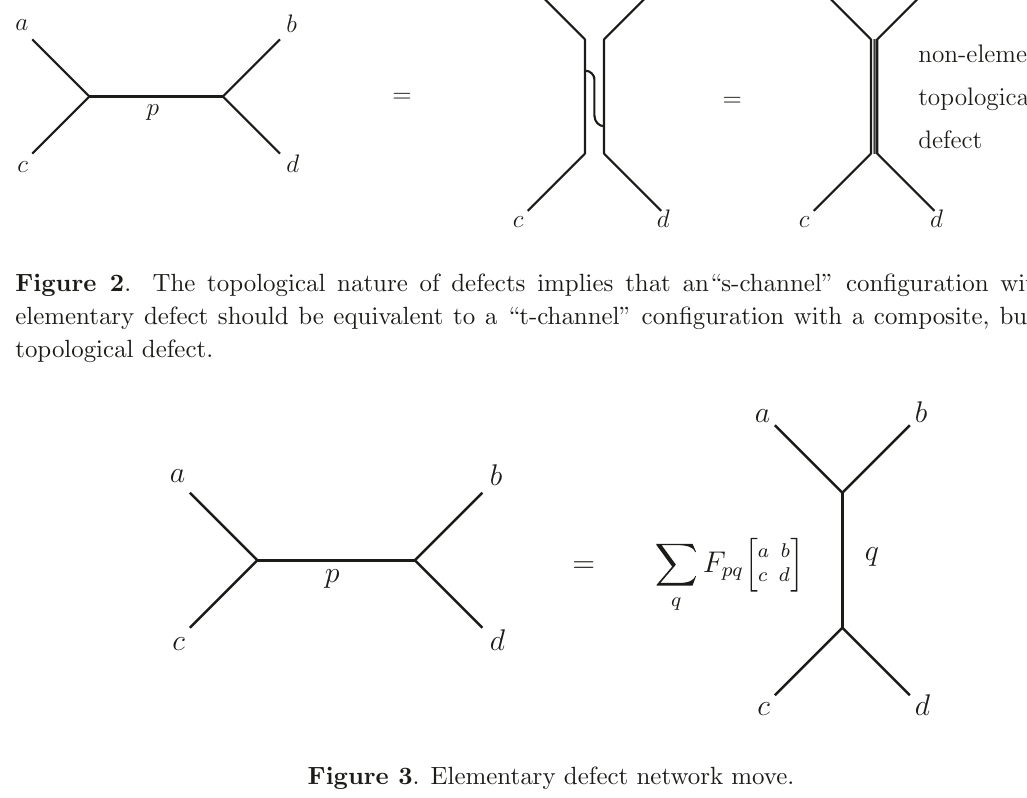
Figure 3 . Elementary defect network